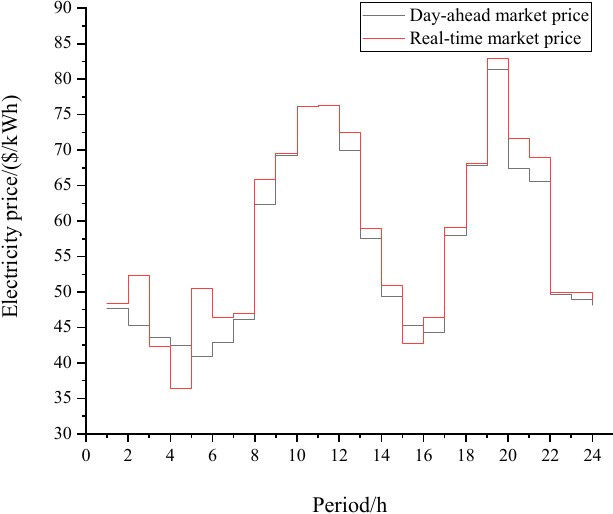
Figure 5. Spot market electricity price forecast chart.